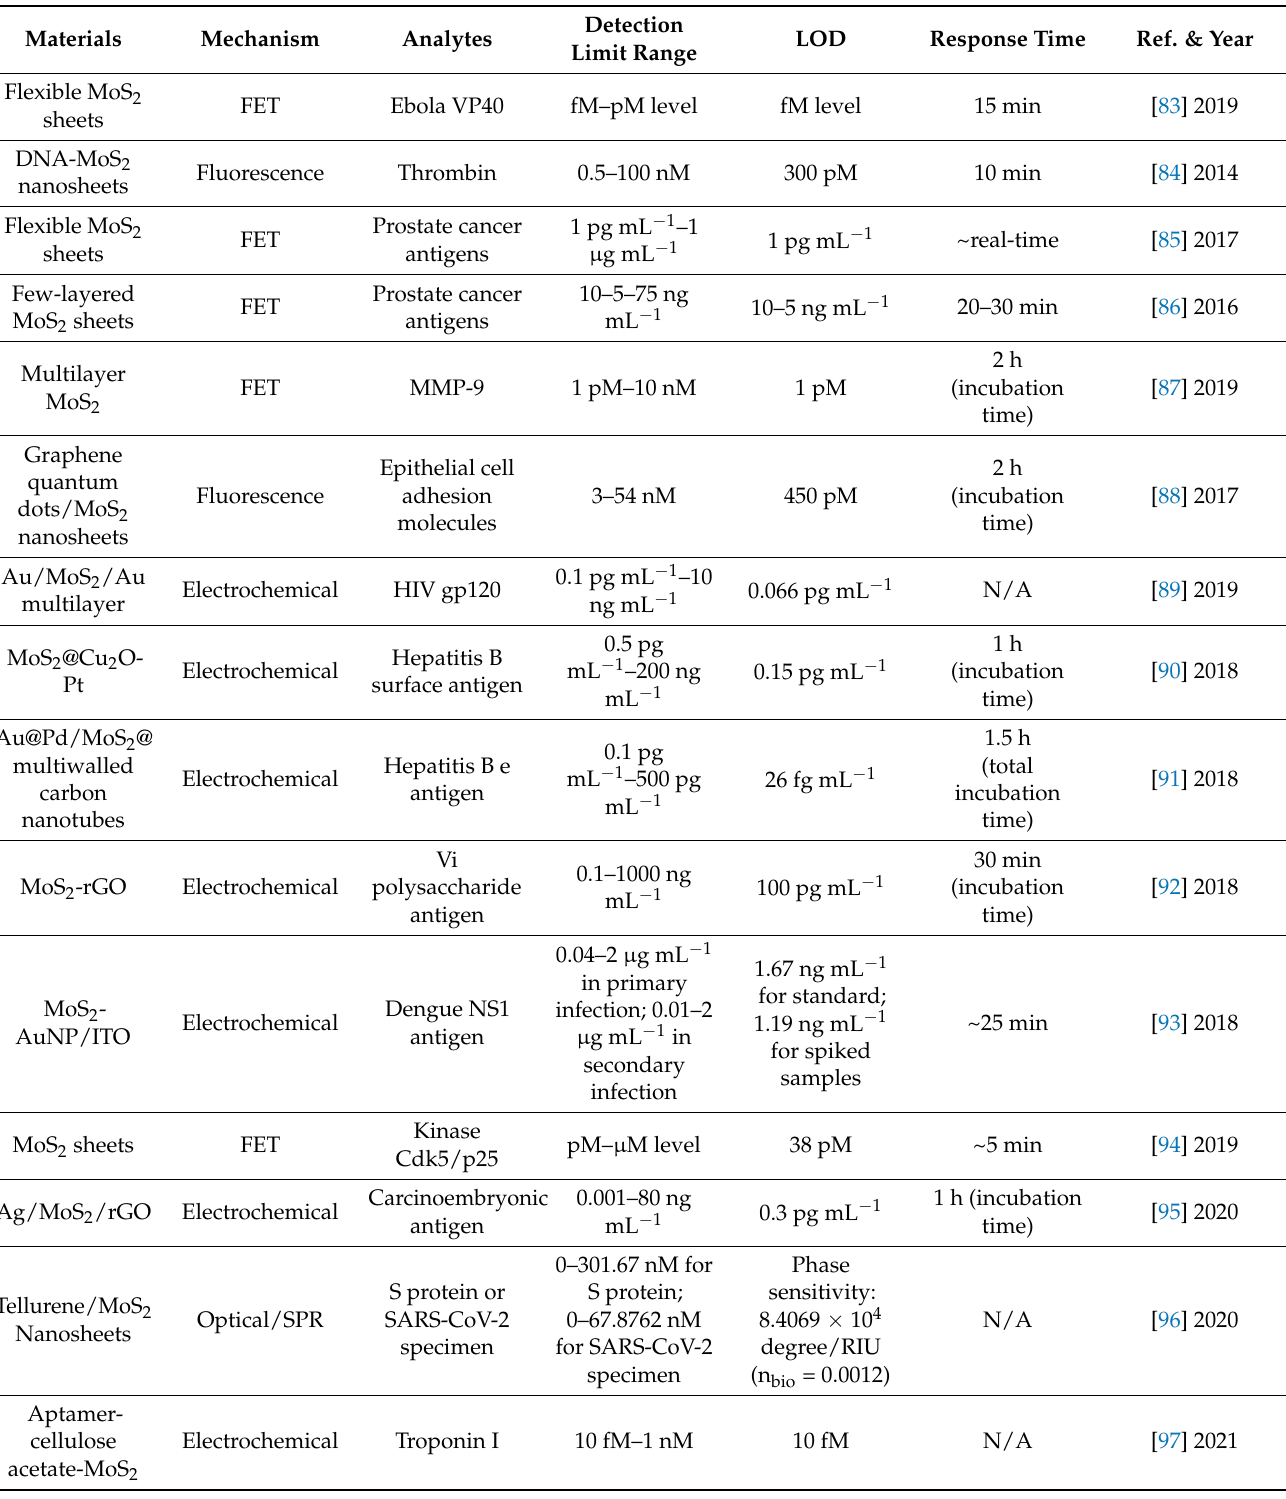
Table 3. Recent 2D TMD-based materials and related mechanisms for probing disease-related proteins and their sensing